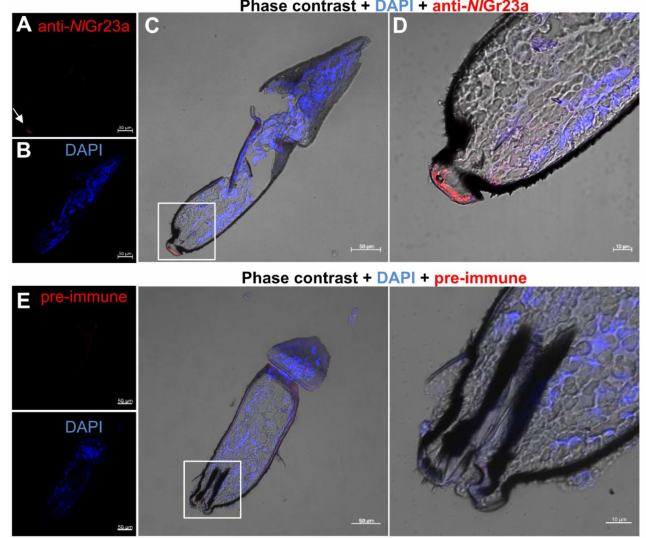
Figure 4. Localization of Nl Gr23a in the distal part of the female labium of the BPH. The labial cryosections were stained with rabbit anti- Nl Gr23a antiserum in combination with Alexa Fluor 555 ® -conjugated goat anti-rabbit IgG. Fluorescence images of anti- Nl Gr23a ( A ), DAPI ( B ), the merged fluorescence image ( C ), and the higher magnification image of the merged image ( D ) are shown. Scale bar represents 50 µ m ( A – C ) or 10 µ m ( D ). Arrowhead points to the cell bodies stained by anti- Nl Gr23a antiserum. ( E ) Negative control experiments were conducted by application of pre-immune rabbit serum taken from the animal immunized with Nl Gr23a peptide to produce the primary antiserum, together with Alexa Fluor 555 ® -conjugated goat anti-rabbit IgG; no immunoreactive cells were observed in the labial tip. Scale bars represent 50 µ m, except for the magnified image, in which the scale bar represents 10 µ